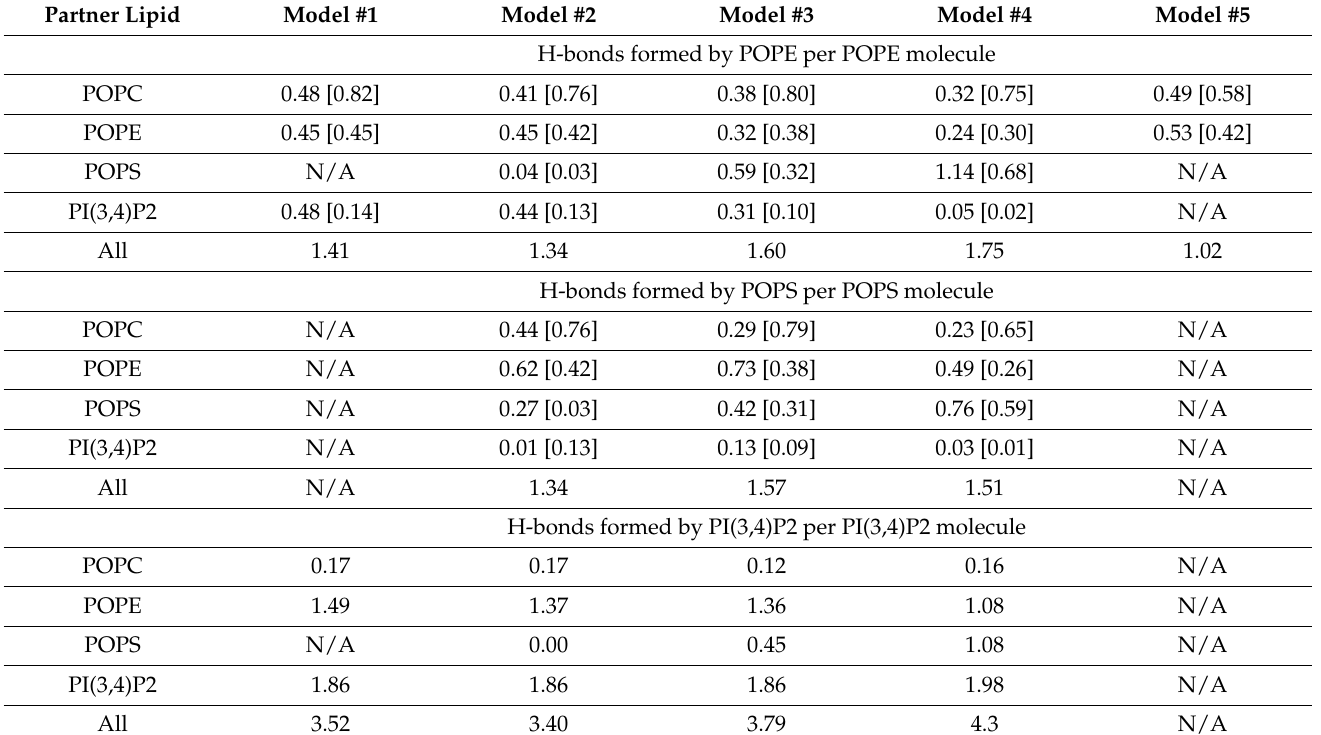
Table 5. Number of direct interactions between lipid molecules: H-bonds and charge pairs. Numbers given in [] are the predicted number based on the lipid concentration only and assuming no other specific interactions. The results marked with an asterisk (*) are calculated for Model #1 but are expected to be equal for Model #2. Not applicable